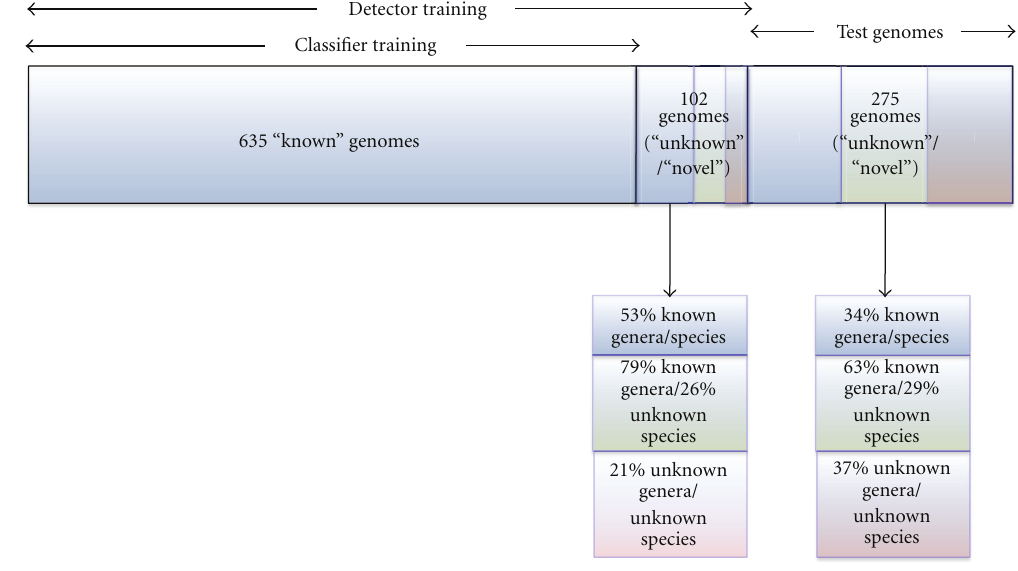
Figure 1: The datasets used in this paper are composed of a classifier training set/database, novel genomes used to train the detector, and a separate novel-genome test set. The blue areas represent the percentage of genomes that have “known” genera/species; the green areas represent the percentage of genomes that are “known” at the genus level but “unknown” on the species level; the red areas represent the percentage of genomes that are “unknown” at both the species and genus